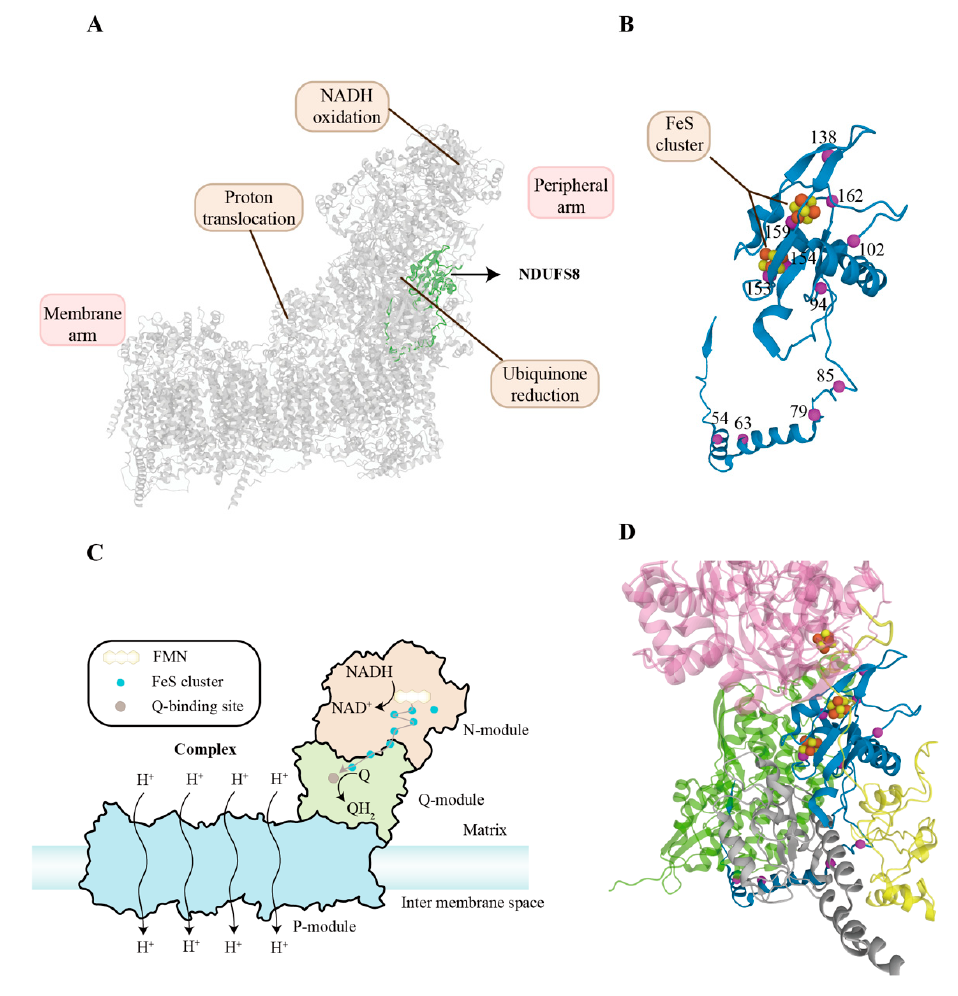
Figure 1. Location, structure, functional mechanism, and clinical pathogenic variants of NDUFS8. ( A ) Cryo-EM structure of human respiratory complex I (CI) with other subunits in grey from 5XTD (EMD- 6773) [8]. The ribbon highlighted in green represents NDUFS8. ( B ) The folds of NDUFS8 are shown in ribbon representation. NDUFS8 contains two [4Fe–4S] 2+/1+ clusters represented by a combination of red and yellow balls. The pathogenic mutation sites of NDUFS8 are presented by magenta balls. ( C ) Schematic representation of components and functions of CI. CI consists of three functional modules: NADH oxidation (N module), ubiquinone reduction (Q module), and proton translocation (P module). They form an L-shape: one hydrophobic arm oriented parallel to the membrane and a hydrophilic arm extending into the mitochondrial matrix. There is a chain of seven FeS clusters that can transfer electrons from FMN to the ubiquinone reduction site. The P module harbors proton-translocation pathways connecting the mitochondrial matrix and the intermembrane space. ( D ) NDUFS8 (blue), NDUFS1 (pink), NDUFS2 (green), NDUFS7 (grey), and NDUFA12 (yellow) of complex I are shown. The annotated pathogenic mutation residues probably have effects on NDUFS8 and its surroundings, leading to complex I dysfunction [28]. Among them, p.Cys153Arg, p.Gly154Ser, and p.Val162Met are associated with the surroundings of two [4Fe–4S] 2+/1+ clusters in NDUFS8, possibly disrupting electron transfer. The p.Ala159Asp lies next to Cys126, a component of the surroundings of two [4Fe–4S] 2+/1+ clusters in NDUFS8. The p.Arg138His is linked to the disruption of electron transfer at the N5 cluster in NDUFS1. Moreover, the p.Arg94Cys is responsible for the impaired interaction of NDUFS8 and NDUFS2, while the p.Pro85Leu is associated with the impaired interaction of NDUFS8, NDUFA12, and NDUFS7. Abbreviations: NDUFS8: NADH:ubiquinone oxidoreductase core subunit S8; NDUFA12: NADH:ubiquinone oxidoreductase subunit A12; FMN: flavine mononucleotide; CI: complex I; NADH: Nicotinamide adenine dinucleotide; Q: